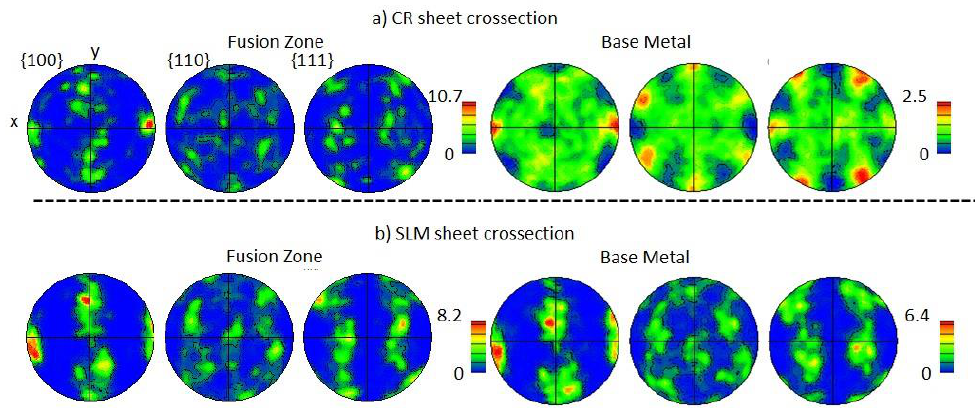
Figure 4. ( a ) (Left) SEM-EBSD inverse pole figure (IPF) X cross-section map of welded CR; (mid- dle) phase map of the heat-affect area (HAZ) and SEM-EBSD inverse pole figure (IPF) X top map of welded CR (right). ( b ) SEM-EBSD inverse pole figure (IPF) X maps of cross-section welded SLM (left), base metal SLM (middle), and top welded SLM (right), respectively. Black lines correspond to random grain boundaries and red lines to Σ3 twin grain boundaries (GB).